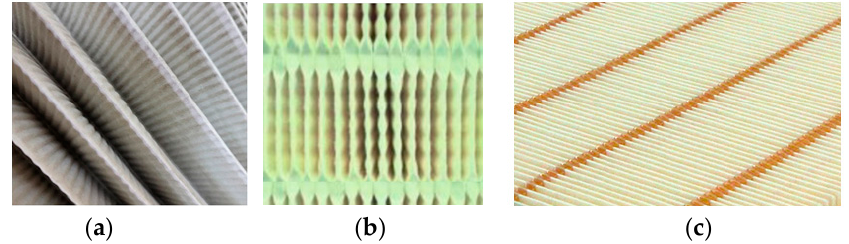
Figure 4. Ways to reinforce pleats: ( a ) pleat surface embossing, ( b ) special thickening of the back of the insert pleat, ( c ) glue trickles.